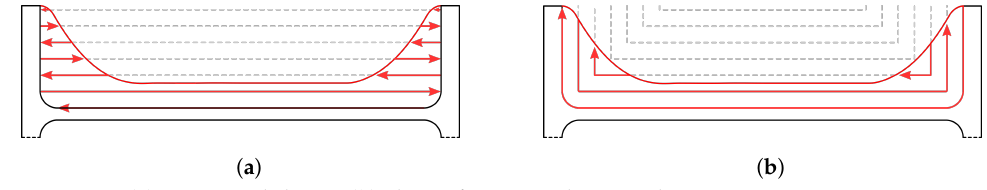
Figure 15. ( a ) Horizontal slicing; ( b ) Slicing from outside to inside.